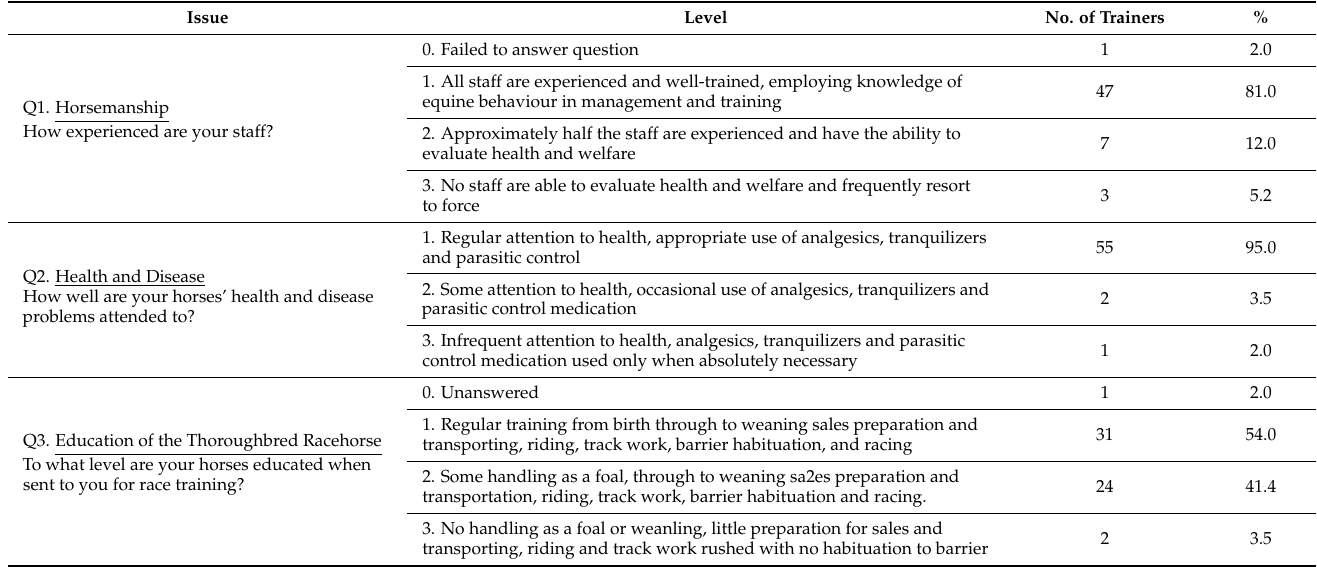
Table 7. Responses of trainers ( n = 58) in the survey of welfare issues and levels for their